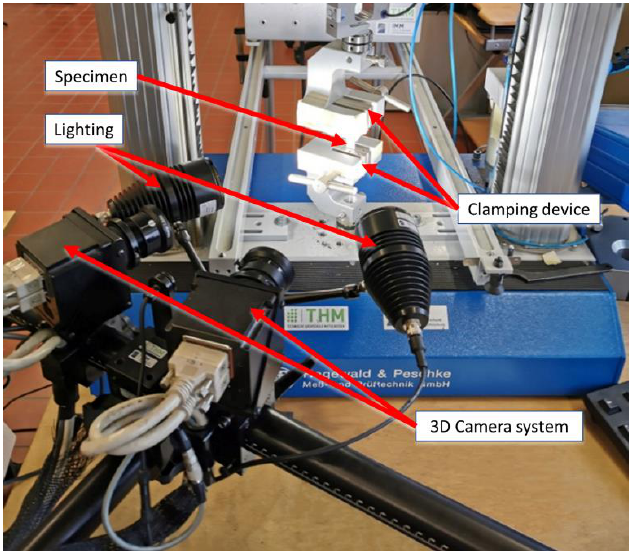
Figure 3. Experimental setup for the tension tests on the polyethylene (PE) isolator specimen.